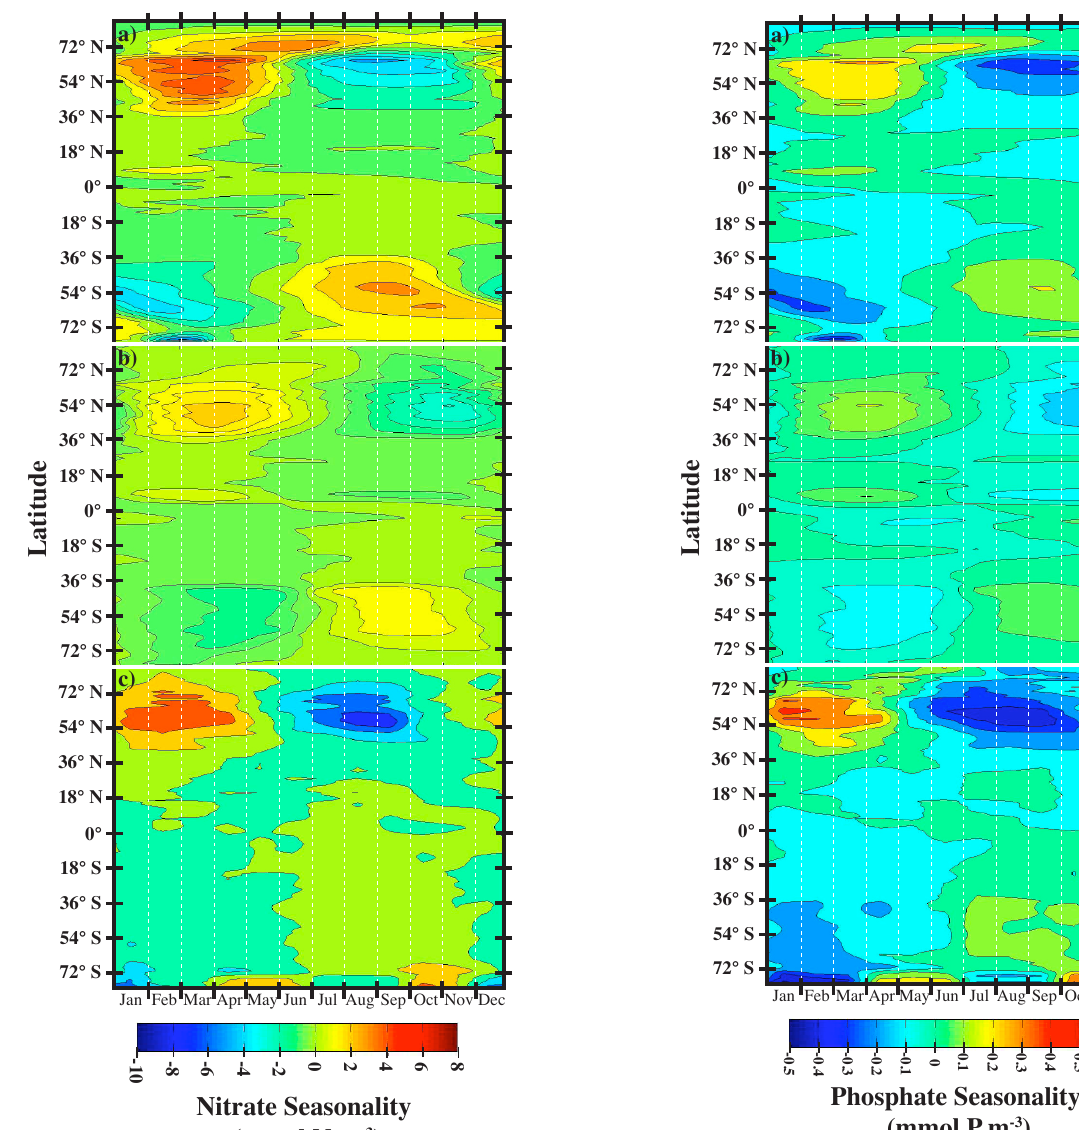
Fig. 11. Hovm¨oller diagrams of the zonally averaged seasonal changes in surface nitrate (monthly climatology minus annual cli- matology) with the new (a) and old (b) models and from the WOA09 database (c) .